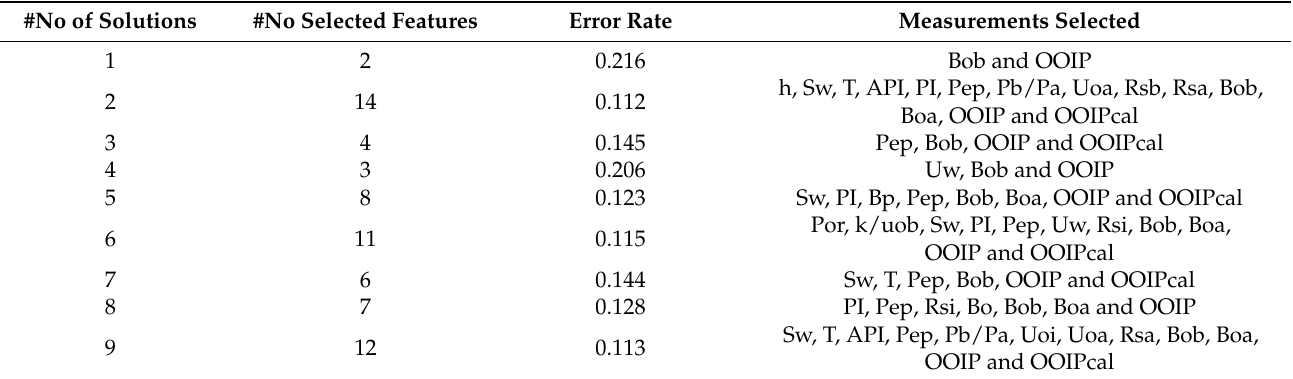
Figure 5. Non-dominated solutions obtained by NSGAII-ANN. Table 6. Results of the NSGAII-ANN.